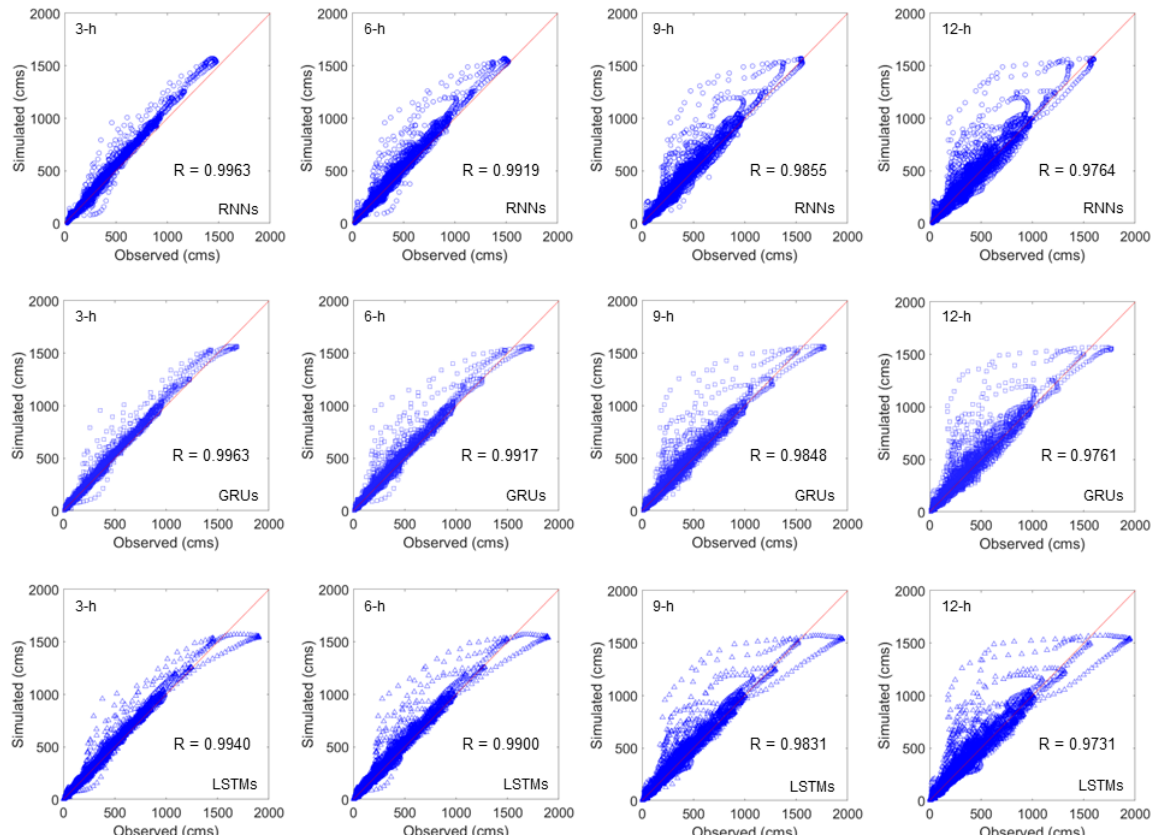
Figure 8. Scatter plots between observed data and the simulated prediction at 3-h, 6-h, 9-h, and 12-h of RNNs, GRUs, and LSTMs using the T C feature representations for the Upper Nan river basin.